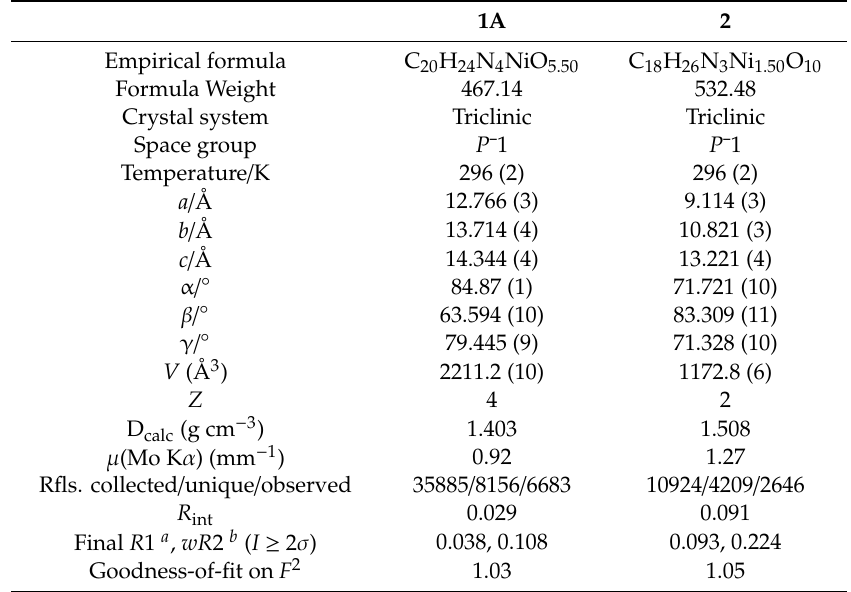
Table 1. Crystal data and structure refinement details for complexes 1A and 2